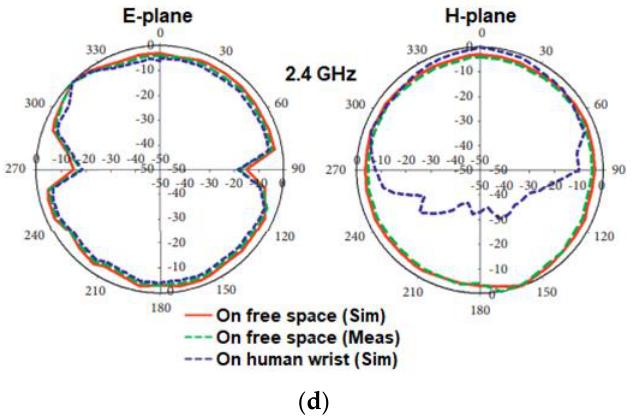
Figure 14. ( a ) The antenna layout. ( b ) S11 curves of the antenna. ( c ) Isolation curve of the antenna. ( d ) Radiation pattern. Reprinted ( a – d ) from Ref. [74].